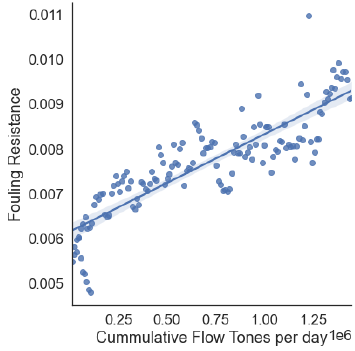
Figure 5. Cummulative Flow Tonnes Per Day vs Fouling Resis-